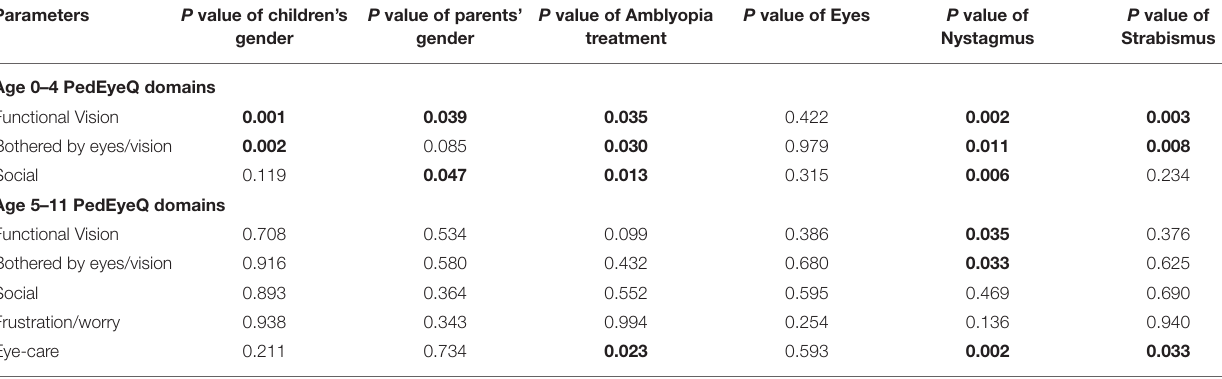
TABLE 3 | Dominating factors on functional vision of age 0–4 and 5–11 PedEyeQ domains.